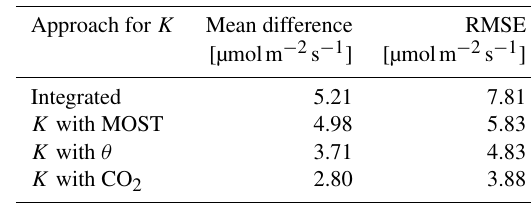
Figure 5. The O 2 concentration plotted against the CO 2 concentra- tion for the representative day in local wintertime (LT; time zone UTC+2), with the 23m level in coloured points per period rep- resenting different dominant process and with the 125m level in grey points. The dominant processes are the following: respiration (00:00–04:00), entrainment (04:00–09:00), assimilation (09:00– 13:00), and a remaining artefact after the pressure correction due to the instability of the MKS pressure transducer becomes visible (13:00–20:00). The linear regression lines indicate the exchange ratio of the atmosphere (ER atmos ) during the time with a specific dominant process.